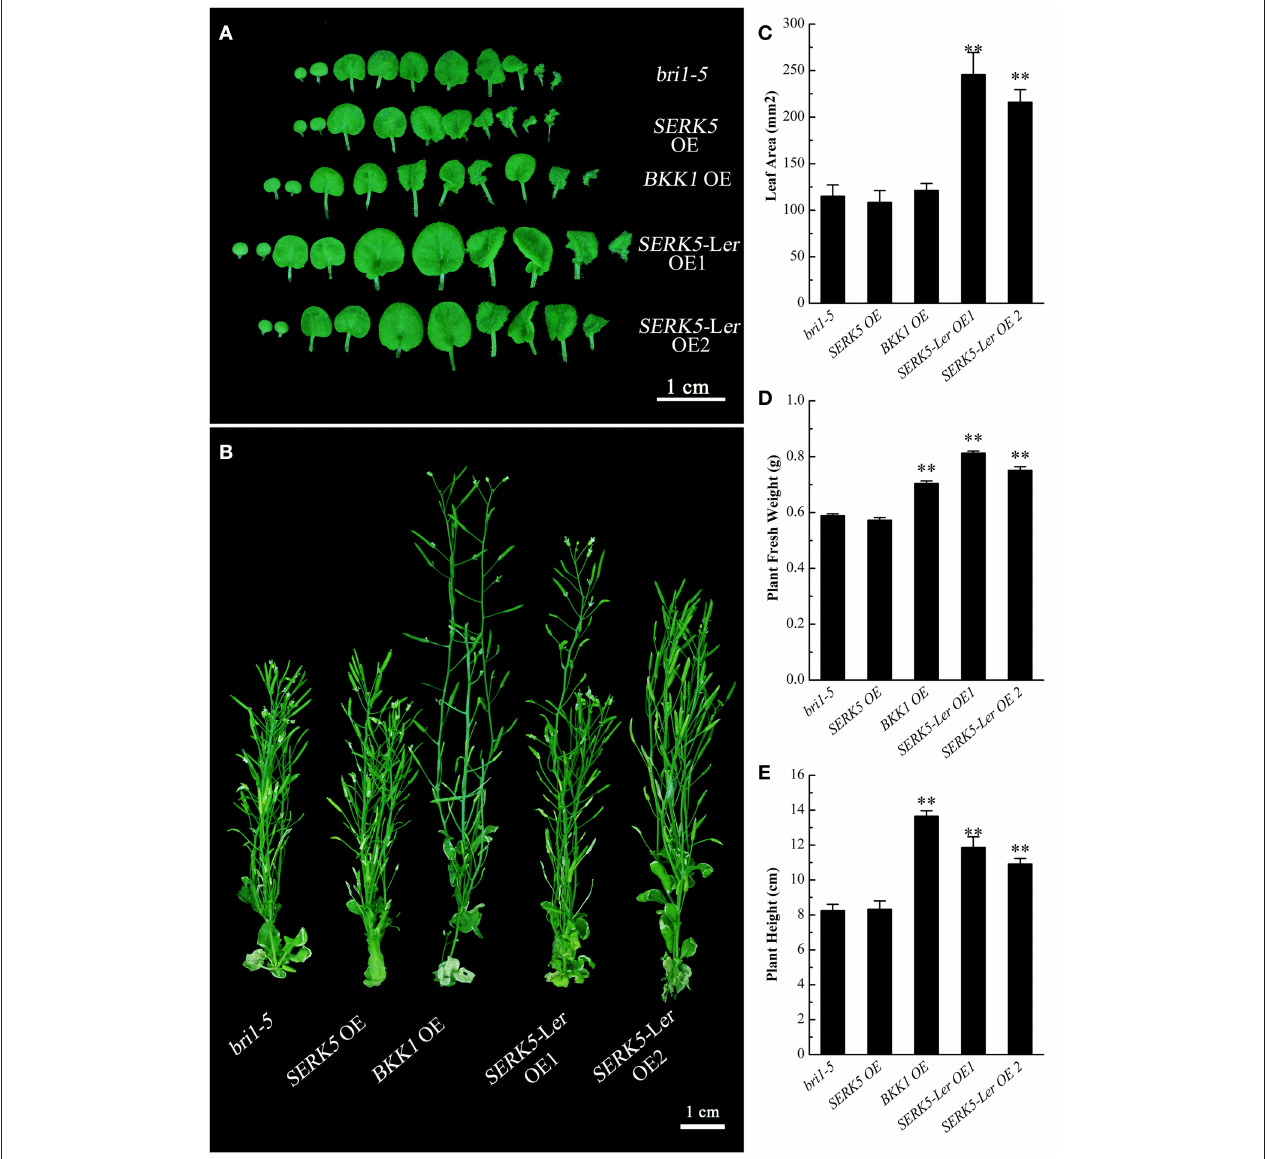
FIGURE 3 | Detailed phenotypic analyses of bri1-5 overexpressing SERKs . (A) Overexpression of SERK5- L er , but not BKK1 and SERK5 , enlarges the leaf size of bri1-5 . (B) Overexpression of SERK5- L er and BKK1 , but not and SERK5 , increases the plant height of bri1-5 . (C) Statistic analyses of leaf areas of the plants presented in (A) . (D) Statistic analyses of plant fresh weight of 35-day-old seedlings. (E) Statistic analyses of plant heights presented in (B) . The data are shown as means ± standard deviation (SD) ( n = 20 ). Student’s t -test indicated the differences are statistically significant ( ** P < 0.01 ). Experiments were repeated three times with similar